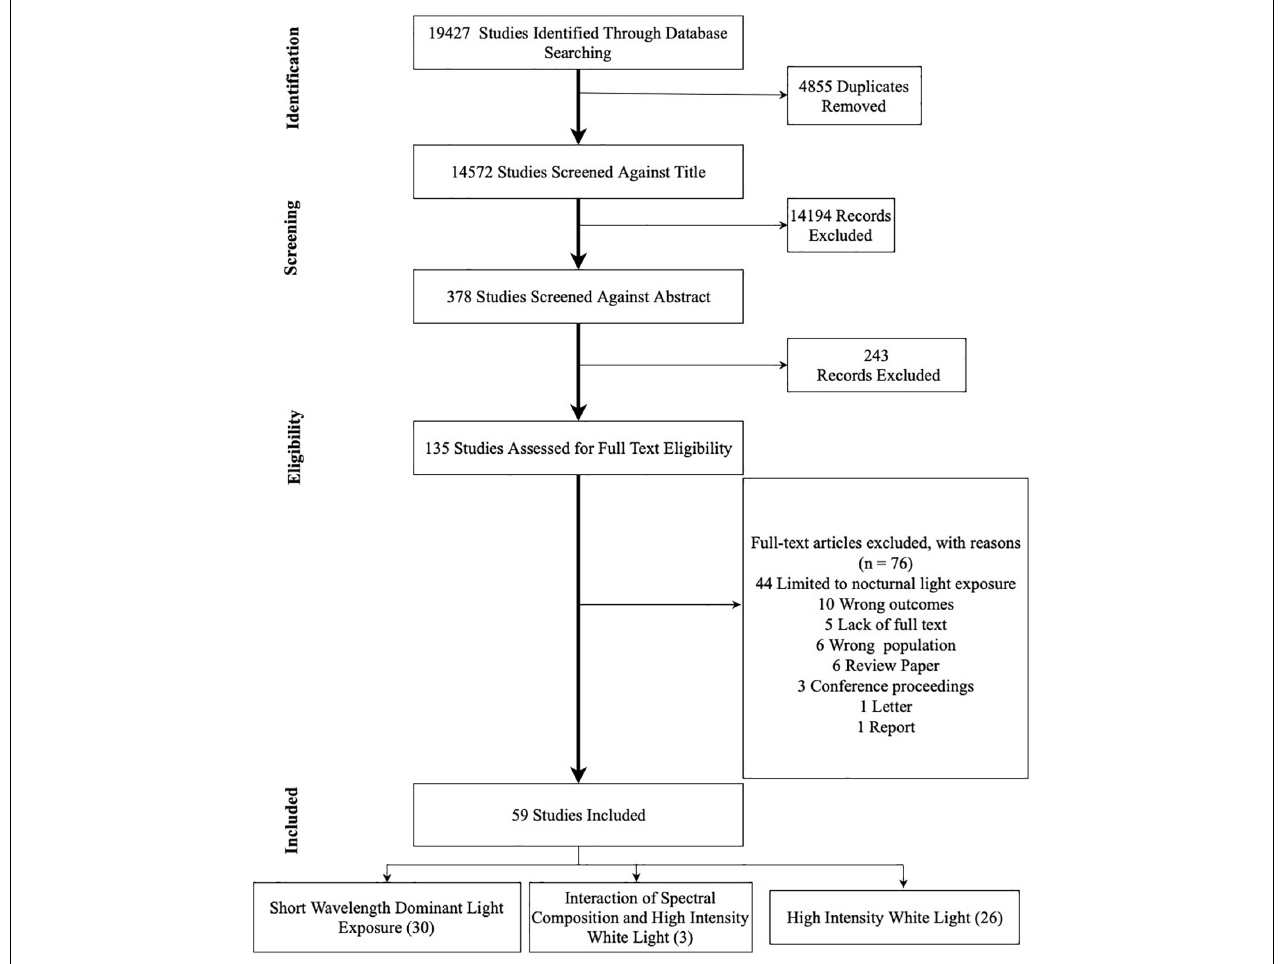
FIGURE 3 | PRISMA flow chart of literature search for publication identification and